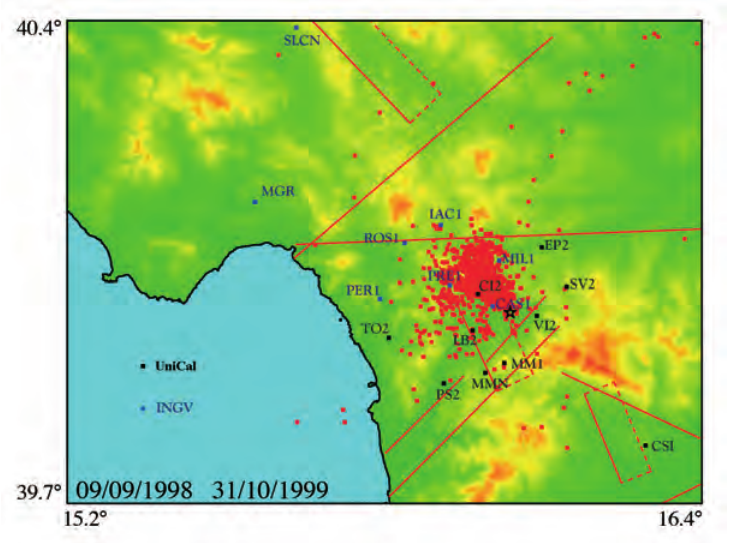
Fig. 3. Event locations throughout the seismic sequence and seismographic stations. Blue squares: INGV sta- tions; black squares: University of Calabria